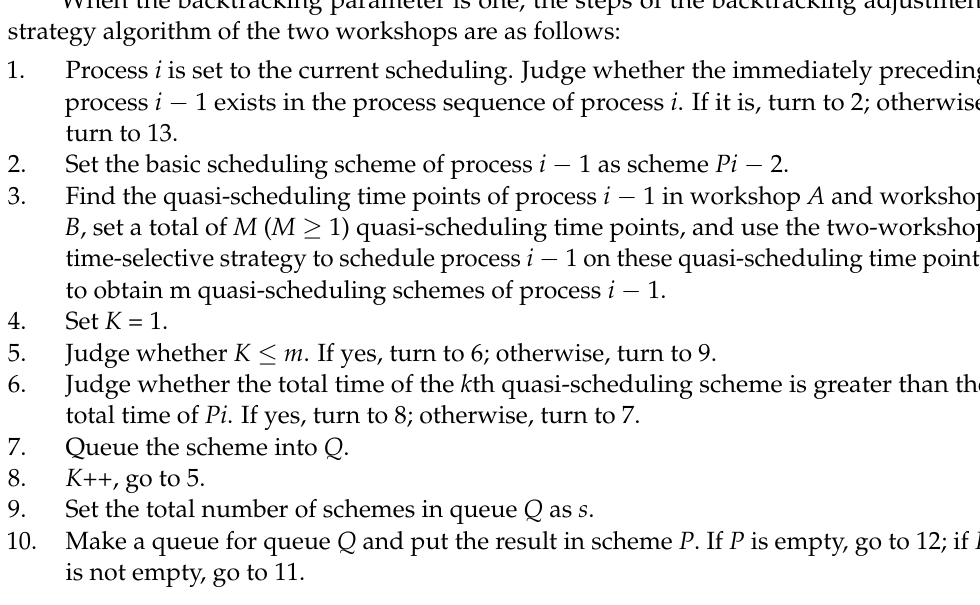
Figure 7. Schematic diagram of backtracking adjustment strategy of two-workshop when the back- tracking parameter is one.